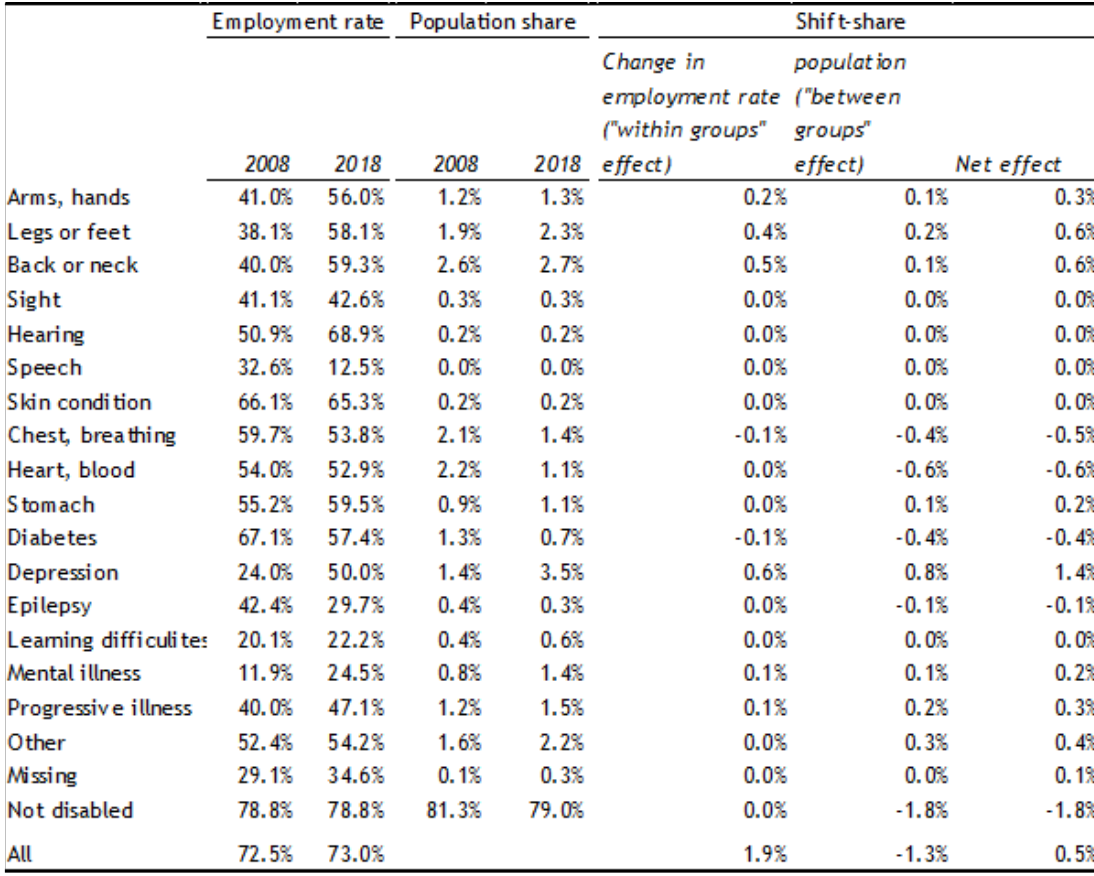
Table 7: Employment and population changes by health problems of